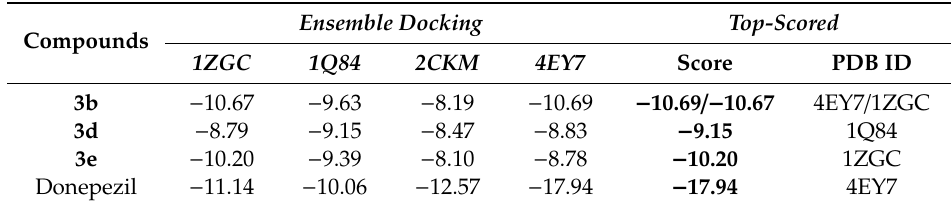
Table 1. Ensemble docking results of compounds 3b, 3e, 3d and donepezil. The top-scored result of each compound is given for the AChE conformation that provided the best docking score according to the Glide XP scoring function (given in kcal / mol). Ensemble Docking Compounds